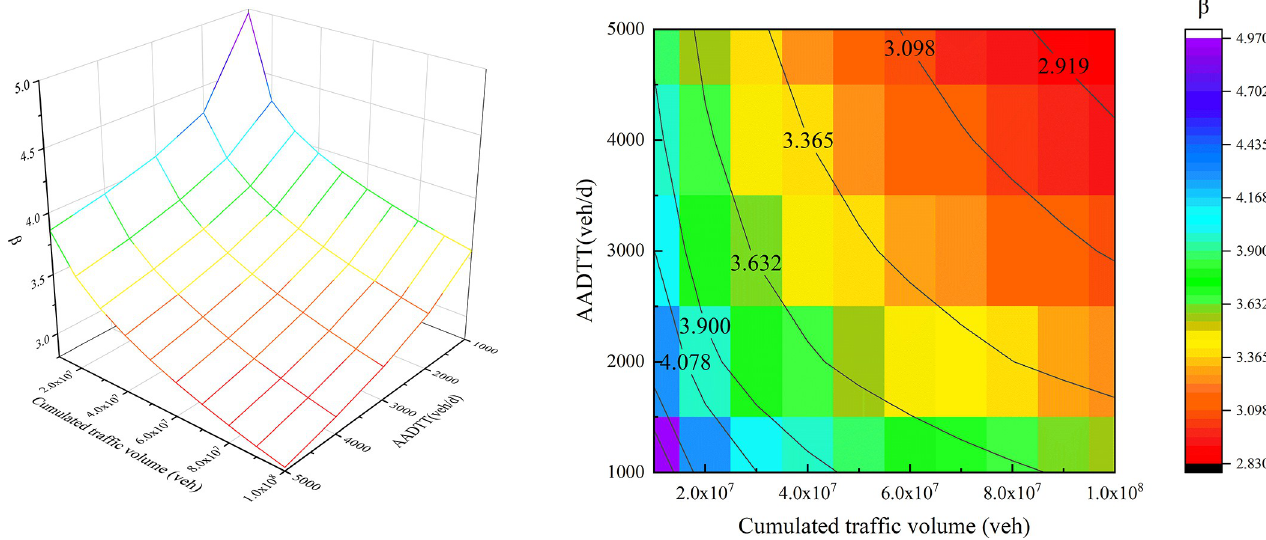
Fig 8. Reliability changes under the action of traffic flow (Car-Z2): (a) 3D surface graph, (b) heat map.